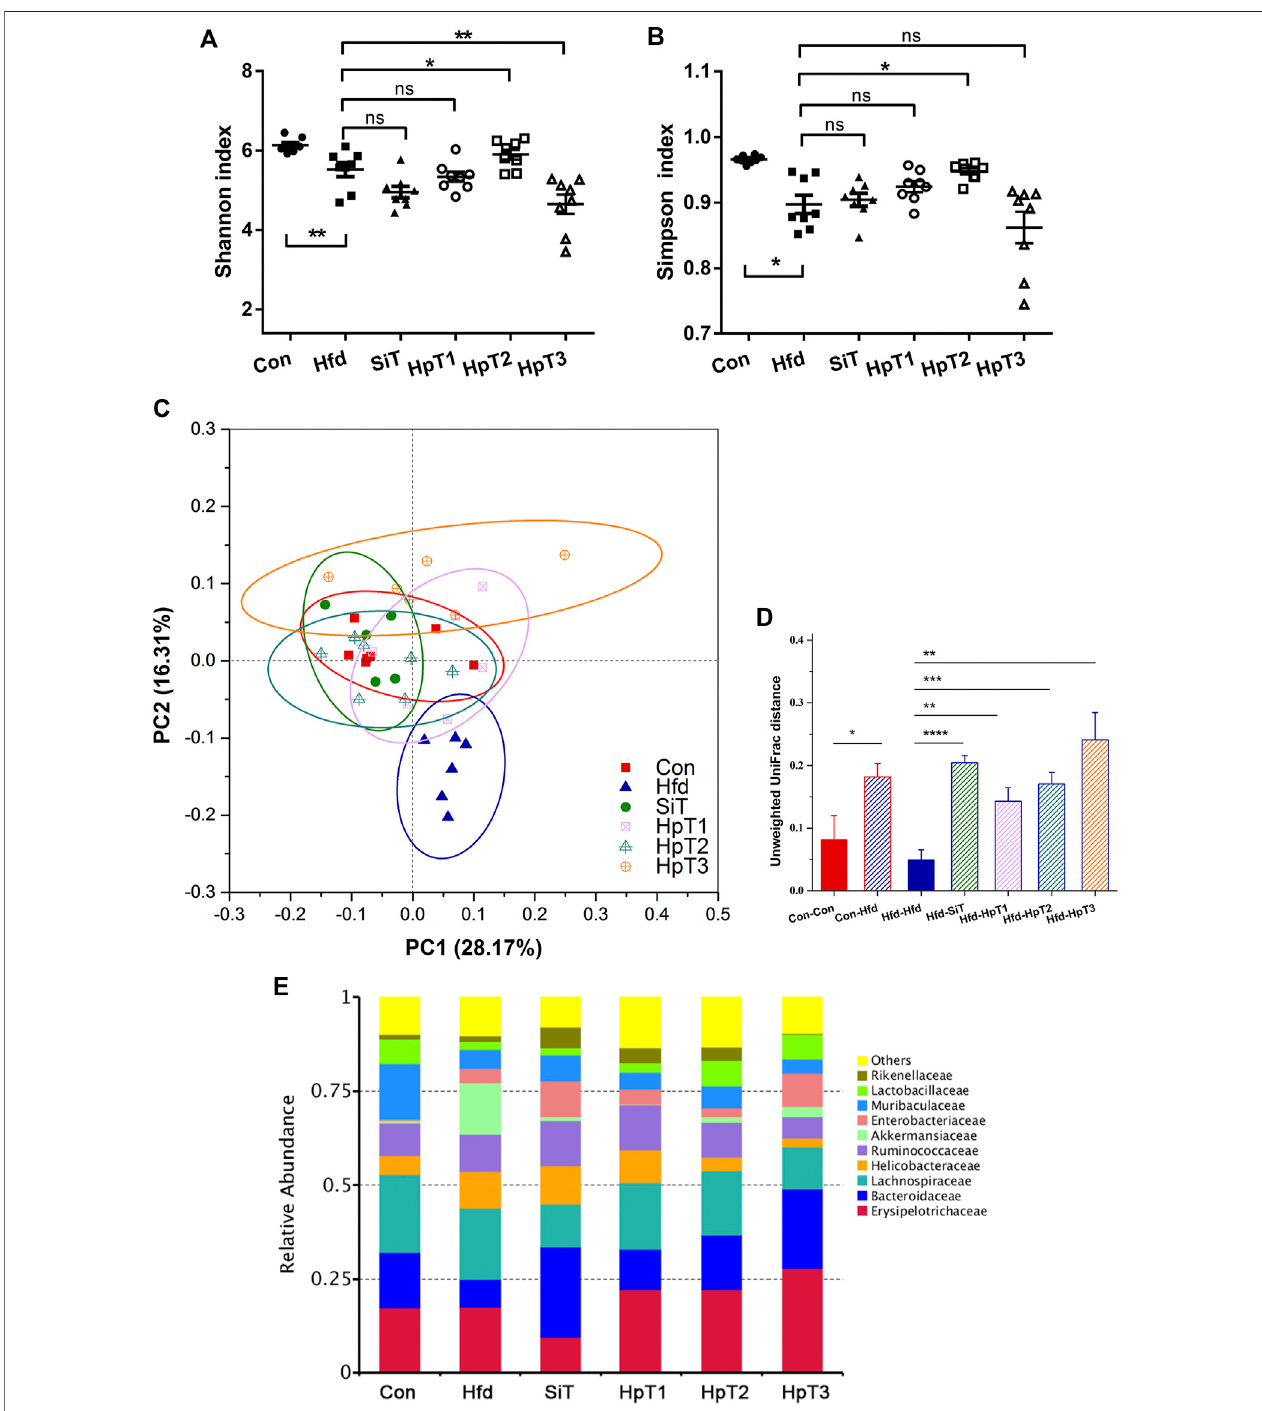
FIGURE 3 | Microbial α , β -diversity and relative abundance in fecal samples indicated a restorative effect of huangjiu peptides following high fat diet-induced gut dysbiosis. (A) α -diversity as measured using Shannon index and (B) Simpson index from different groups. Data were presented as mean ± SEM of six to nine mice per group. Two-tailed t -test was used to determine statistical signi fi cance, * p < 0.05, ** p < 0.01, ns means no signi fi cant differences. (C) Principal coordinates analysis (PCoA)clari fi eddifferencesinmicrobialcommunitystructurebetweendifferentgroups.The fi rstprincipalcomponent(PC1)andsecondprincipalcomponent(PC2) explained28.17and16.31%ofthevarianceintheunweightedUniFracmetrics,respectively.Eachpointrepresentsthefecalmicrobiomeinasinglesample. (D) Pairwise distance based on unweighted Unifrac distance measurementsand Euclidean distance calculation ofmicrobiota in fecal samplesfrom different mice groups. Data were presented as mean ± SEM of the distances. Unpaired two-tailed t tests were used to determine statistical signi fi cance between groups, * p < 0.05, ** p < 0.01, *** p < 0.001, **** p < 0.0001. (E) Alterations of top 10 microbial community at a family level in different groups.